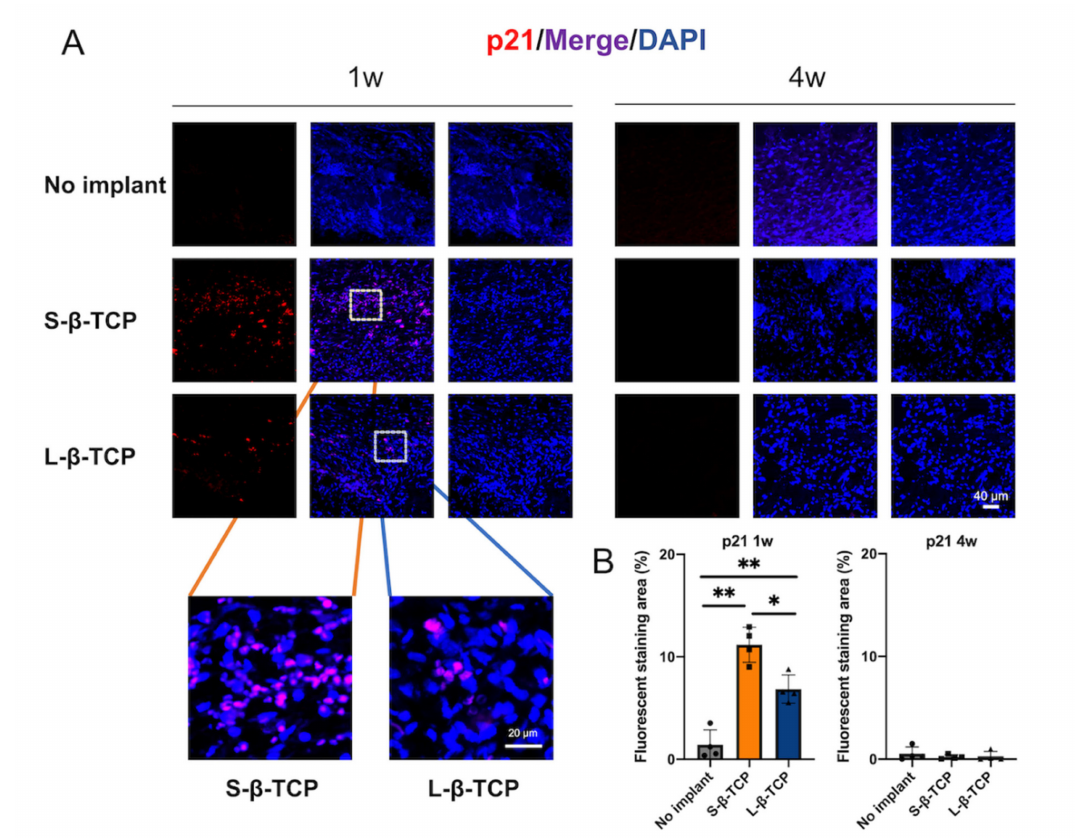
Figure 3. Identification of cellular senescence in bone defects at one week and four weeks after the operation. ( A ) Immunoflu- orescent images of bone defects stained with p21 antibody and 4 (cid:48) ,6-diamidino-2-phenylindole (DAPI) (scale bar = 40 µ m); ( B ) p21 quantified protein level at region of interest (ROI) in bone defect. Data are presented as the ratio of protein immunofluorescent area to nucleus area. Mean with SD ( n = 4). * p < 0.05, ** p < 0.01: One-way ANOVA analysis with Tukey–Kramer method as post hoc